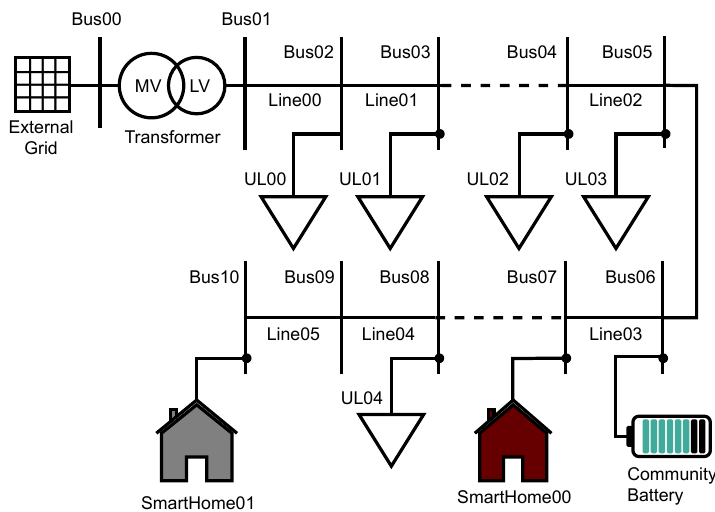
Figure 2. General schematic of a three-phase unbalanced distribution grid with a medium- voltage/low-voltage transformer, uncontrollable loads (UL), smart buildings and a community battery system.